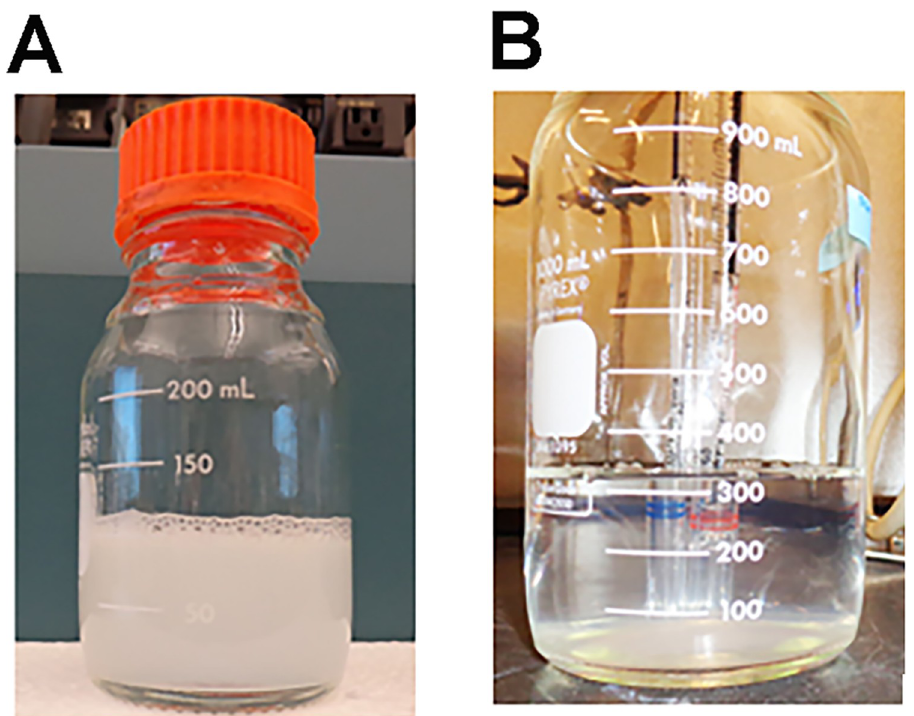
Fig 2. Concentration and diafiltration in the Pellicon 2. A) A pump speed of 80 rpm (9 L permeate per hour) was used for concentration and buffer exchange (diafiltration) of BChE in the Pellicon. 1.7 g of BChE in 5 L of 20 mM sodium phosphate pH 8.0 plus 0.1 M TMA was concentrated to 50 mL followed by diafiltration to yield 1.6 g of BChE in 0.1 L of PBS. The end-product was turbid. B) Using a pump speed of 6 rpm (333 mL permeate per hour) BChE